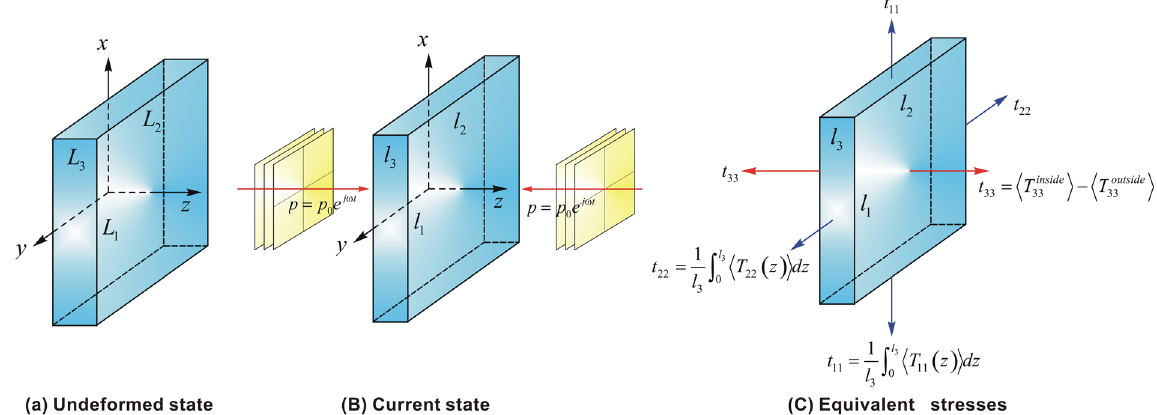
Figure 1. Deformation of a thin hyperelastic layer induced by acoustical radiation stresses. ( a ) In reference state, the layer has dimensions ( L 1 , L 2 , L 3 ). ( b ) In current state, the layer deforms to dimensions ( l 1 , l 2 , l 3 ) under two opposing sound pressure inputs p L = p 0 e j ω t and p R = p 0 e j ω t in the left and right sides of the medium, respectively. ( c ) Equivalent stresses induced by acoustic radiation